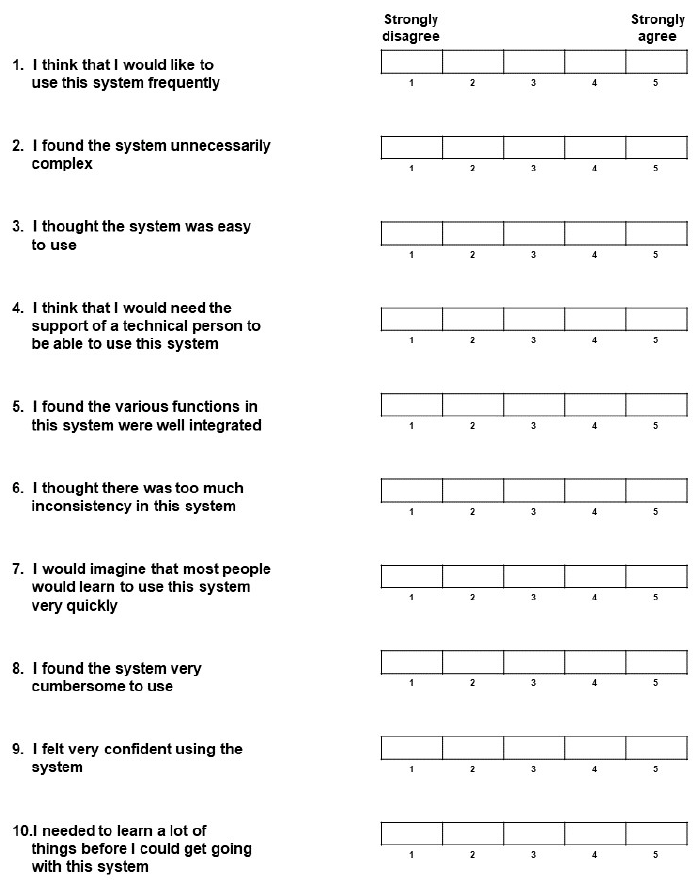
Figure 4. System usability scale (SUS) Questionnaire.